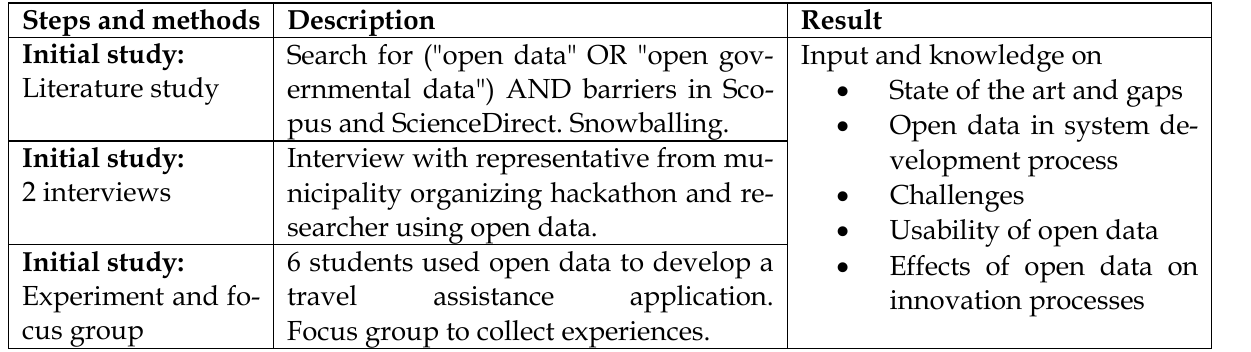
Table 1 Survey on barriers and drivers of easily usable open data – data collected and data analysis